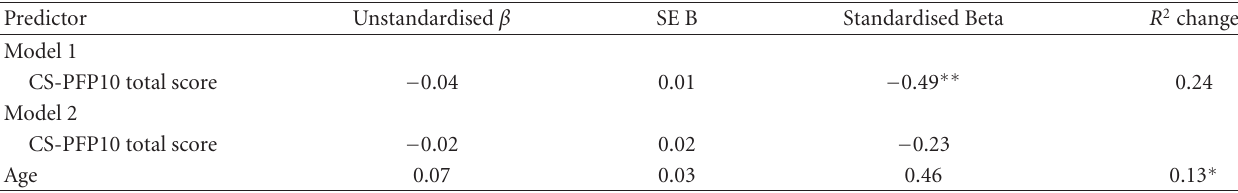
Table 3: Multiple linear regression model predicting falls risk.